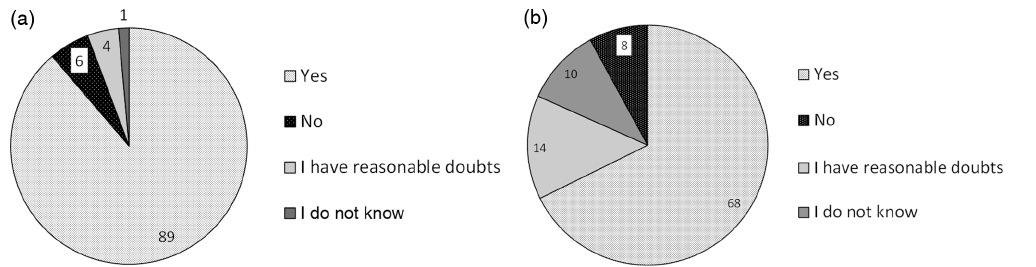
Figure 1. Do you think that human activities contribute to climate change? (a) Survey general public (percentage of N = 630); (b) survey municipality mayors (percentage of N =